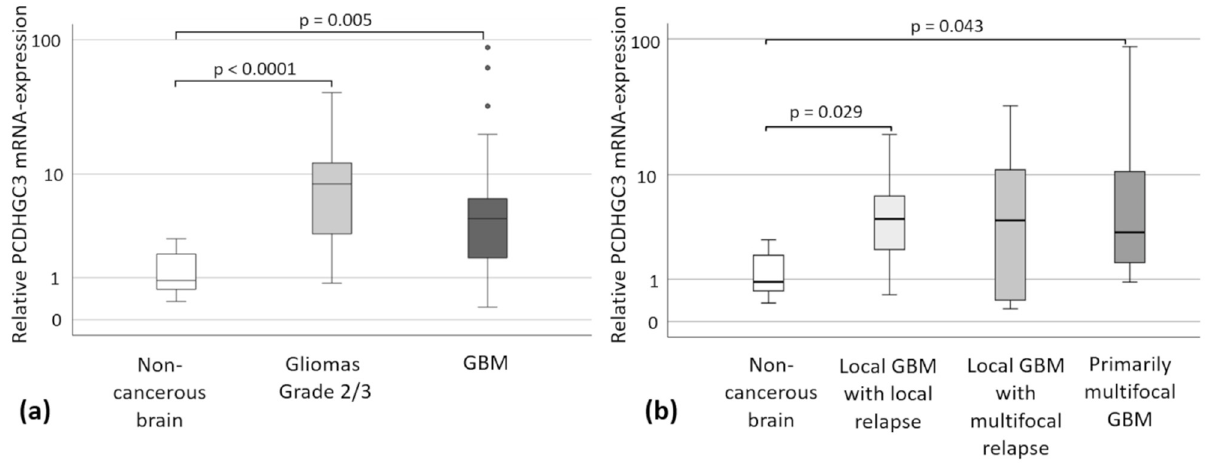
Figure 2. PCDHGC3 mRNA expression of gliomas grade 2/3 and GBM subgroups. Circles mark statistical outliers. Kruskal–Wallis test, post-hoc: Dunn’s test, correction of the significance accord-